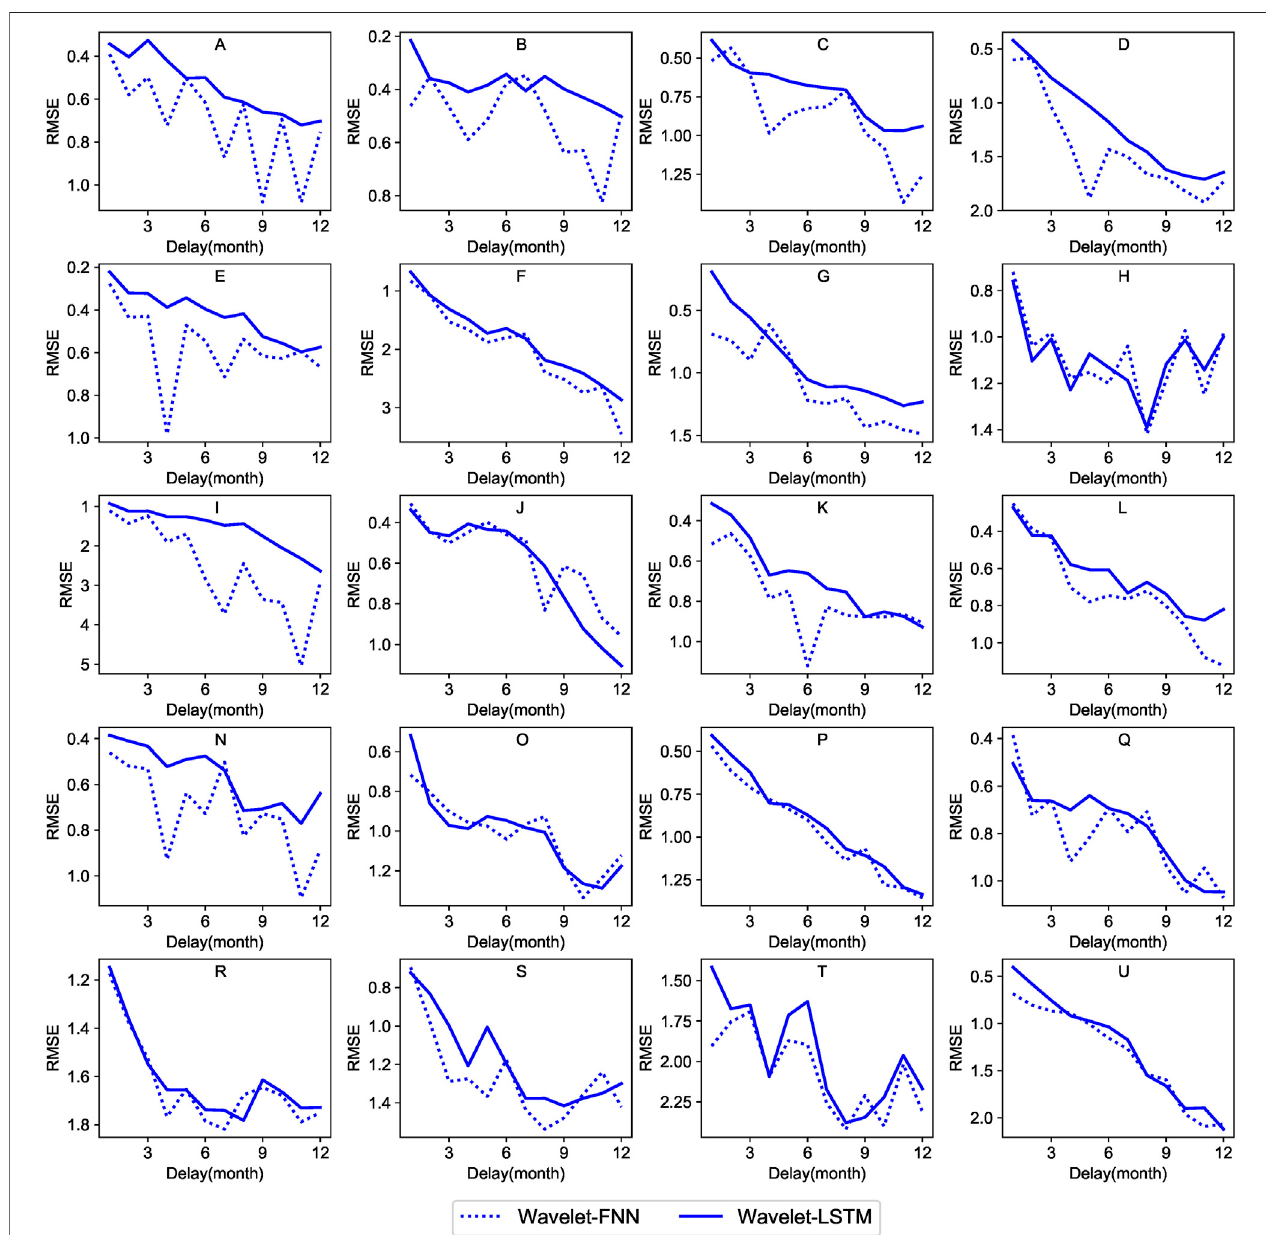
FIGURE 9 | Comparison of RMSE values of water table depth using wavelet-LSTM and wavelet-FNN models with 1 – 12 months delays.